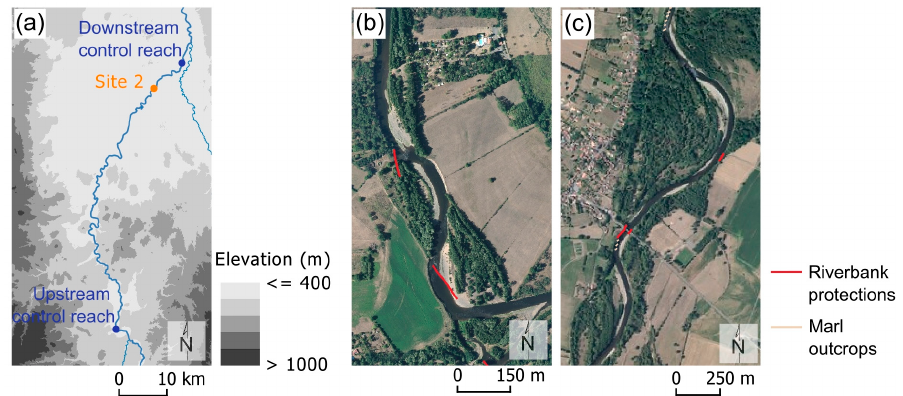
Figure 3. ( a ) Location of the two control reaches. ( b ) Upstream control reach. ( c ) Downstream control reach. Map background: 2019 orthophotography produced by IGN.